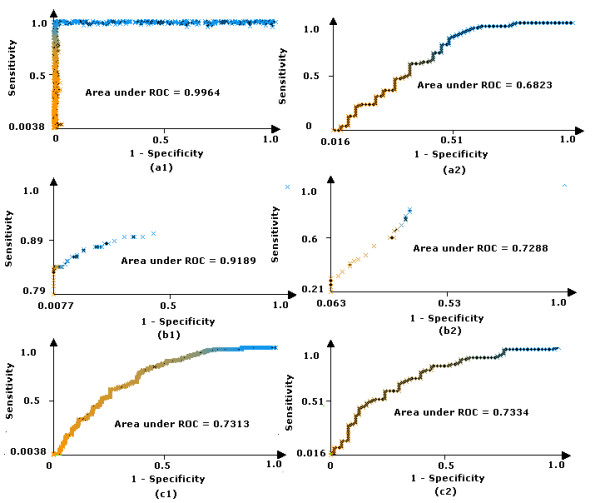
The ROC curves for three classifiers using random over-sampling and under-sampling methods. Figure (a1) KStar with over-sampling method; (a2) KStar with under-sampling method; (b1) C4.5 with over-sampling method; (b2) C4.5 with under-sampling method; (c1) MLP with over-sampling method; (c2) MLP with under-sampling method. The blue and yellow lines in ROC curves represent the different threshold values which are used to generate ROC.